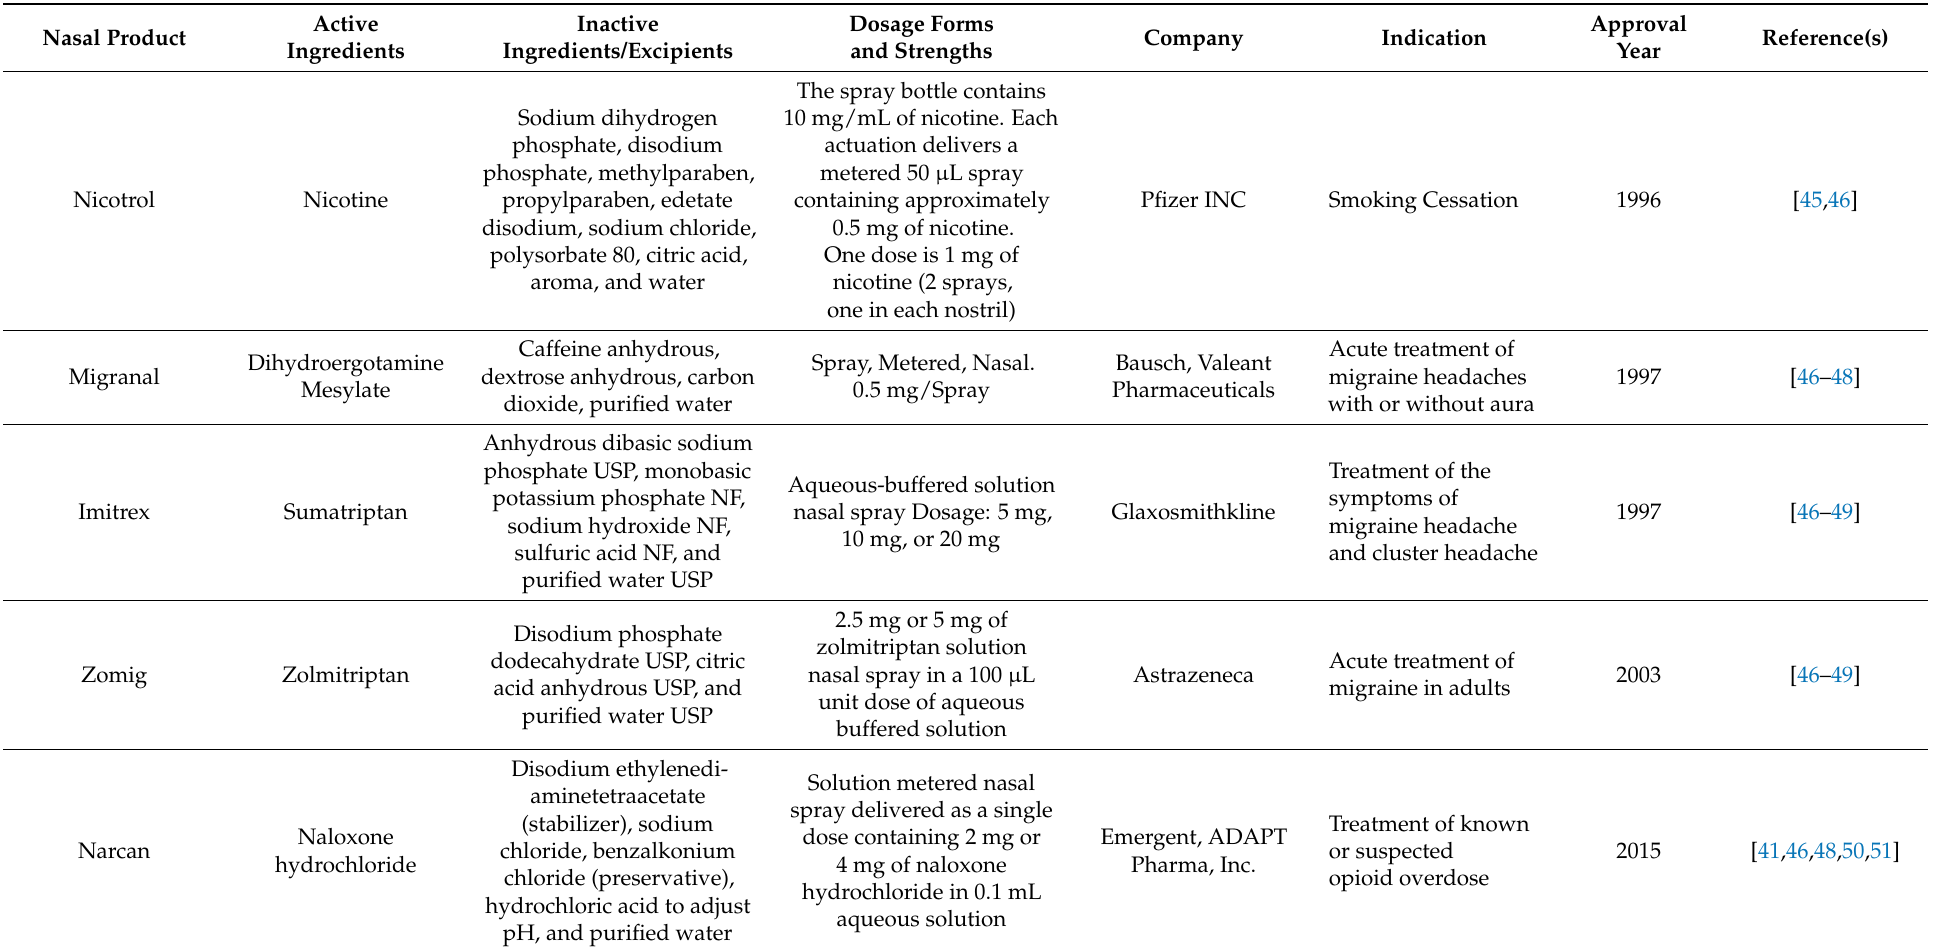
Table 2. The current FDA-approved small molecule drug (non-protein/non-peptide) nasal products delivered to the